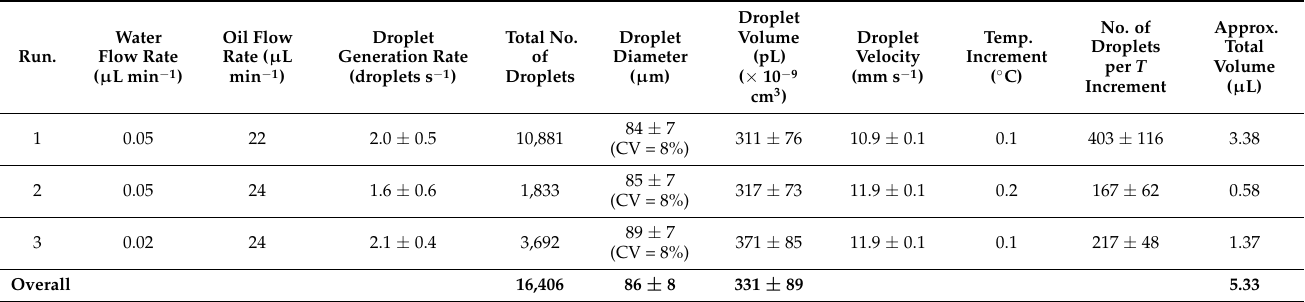
Table 1. Experimental parameters and droplet characteristics for three experimental runs for studying the homogeneous freezing of purified water droplets.